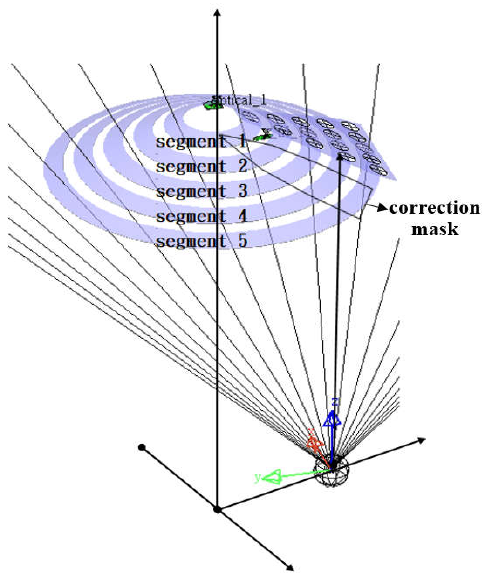
Figure 2. The geometric position distribution of the evaporation coater, including electron gun, ion assisted deposition (IAD), quartz monitoring sensor, optical monitoring system, mask and the coating substrate holder.